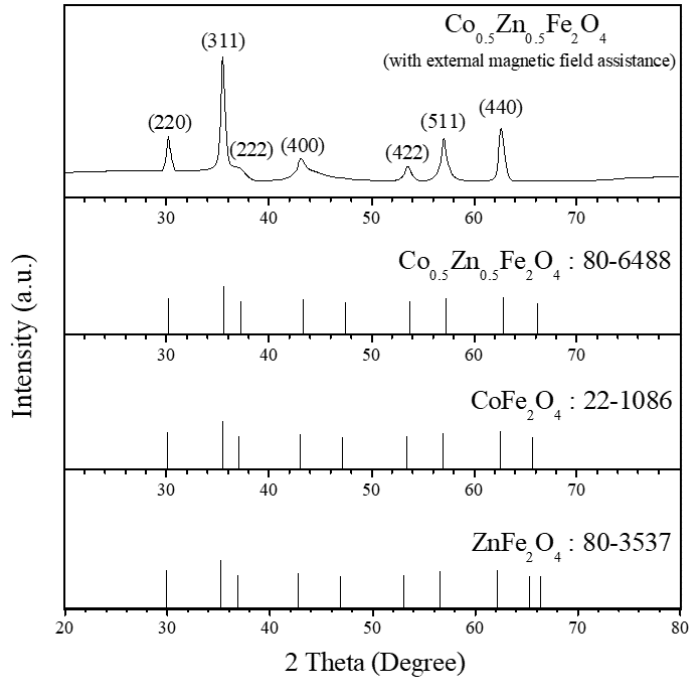
Figure 2. Indexed X-ray diffraction pattern for chitosan-coated Co 0.5 Zn 0.5 Fe 2 O 4 nanoparticle calcined powders at 500 °C with 400 mT of magnetic field assistance.